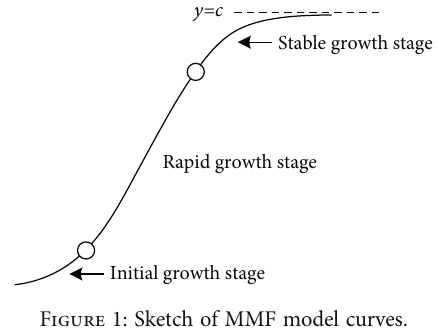
Figure 1: Sketch of MMF model curves.